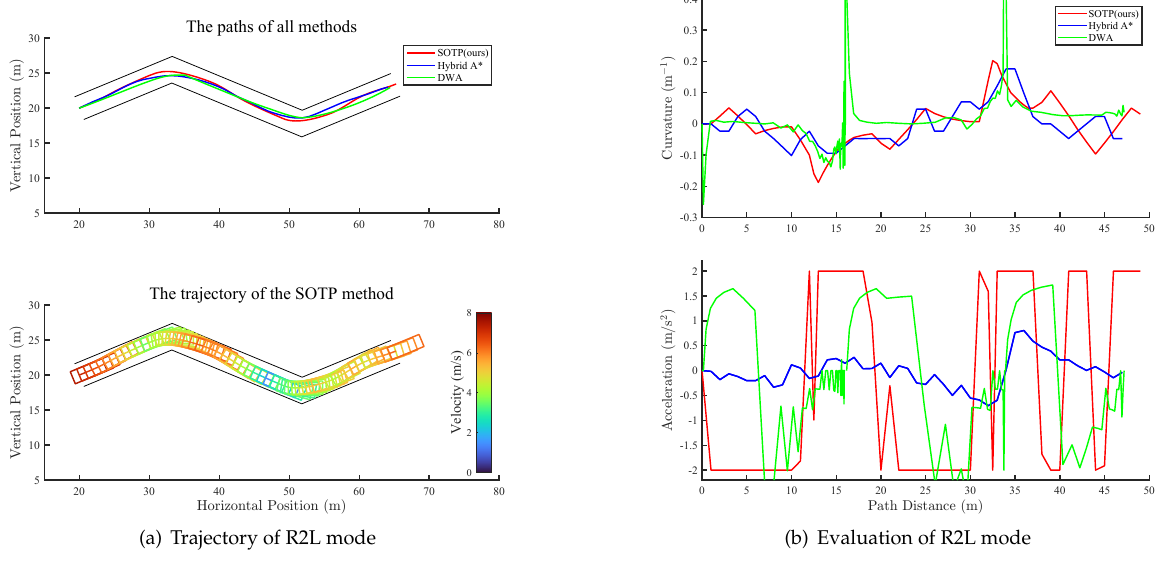
Figure 10. Trajectory generated by all methods in the narrow corridor scene with heat distribution indicating the velocity change. ( a ) the trajectory planned in the R2L mode. ( b ) the curvature and acceleration profile of the trajectories in the R2L